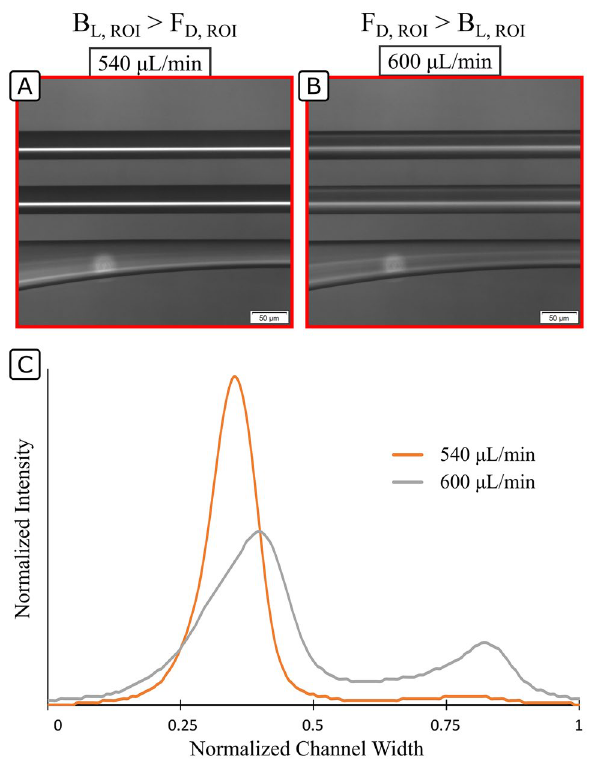
Figure 3. Performance of a HARC system with two loops, 41 × 84 µm ( WxH ) and R 25 mm with 4 µm polystyrene particles. At 540 µL/min, the particles are stopped by the Lift Barrier and a high-quality focus line is obtained by the inner wall. At 600 µL/min, the particles are not stopped by the Lift Barrier and remain unfocused. ( A , B ) View under the microscope. ( C ) Intensity profile.